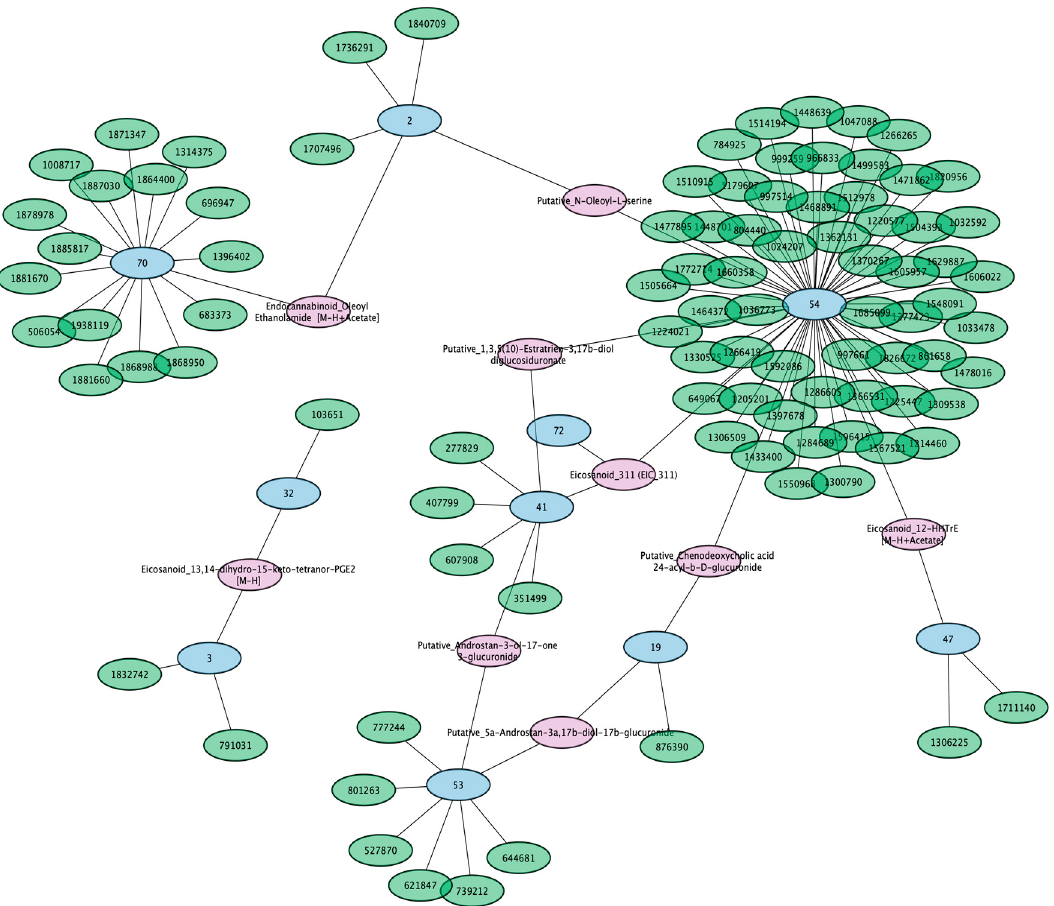
Figure 7. Several identified metabolites were associated with multiple distinct loci. Genomic loci are indicated by blue nodes. All green and purple nodes are identified metabolites. For improved visualization, only those associated with multiple distinct loci are shown in purple and have their identities shown in the figure. The identities for all the green metabolite nodes are listed in Supplementary Table S4. Notably, the eicosanoid EIC_311 is associated with 3 distinct genomic loci, consisting of genomic locus 41 (containing regions relating to the CYP3A genes), genomic locus 54 (containing regions relating to the SLCO genes), and genomic locus 72 (containing regions relating to the SULT2A1 gene). Table 3. Eight identified metabolites are associated with two distinct genomic loci. Only one identified metabolite, an eicosanoid identified as EIC_311, was associated with three distinct loci, but eight others were associated with two, suggesting a more specific regulation. Some metabolites are presented twice because their identities are expected to be the same despite minor differences in their MZ or RT